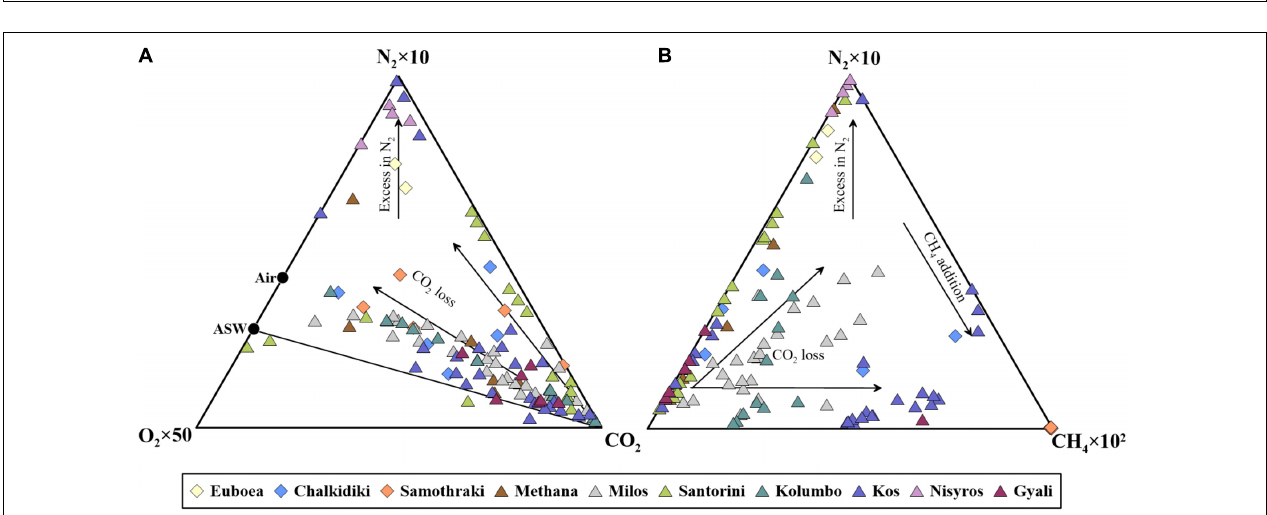
FIGURE 5 | Gas sampling with the use of the inverted funnel method at Kefalos (Kos Island). Note that the funnel was constructed at the mechanical laboratory of Istituto Nazionale di Geofisica e Vulcanologia, Sezione di Palermo (INGV-Palermo). Additional photos regarding the sampling technique are provided in Supplementary Figure 1 . Photo courtesy of SC.